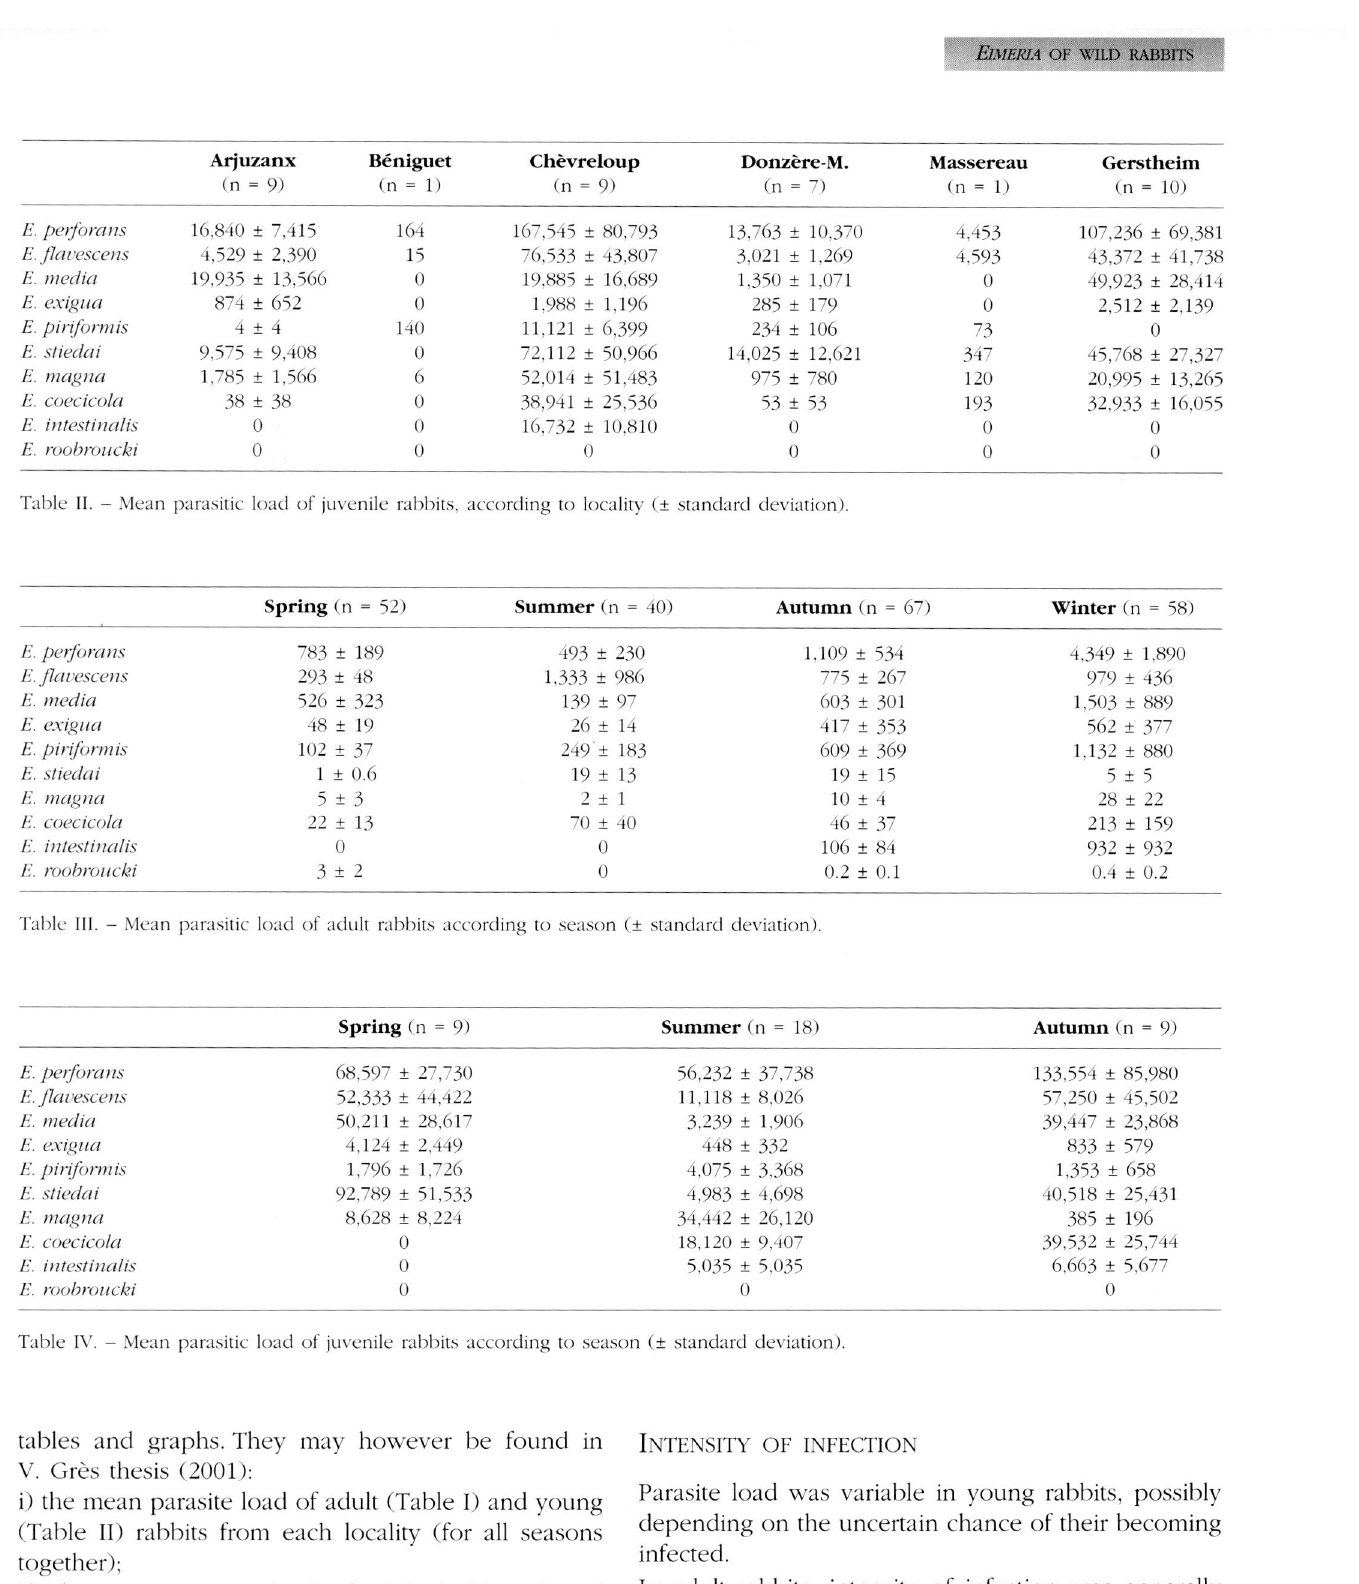
Table II. - Mean parasitic load of juvenile rabbits, according to locality (± standard deviation).